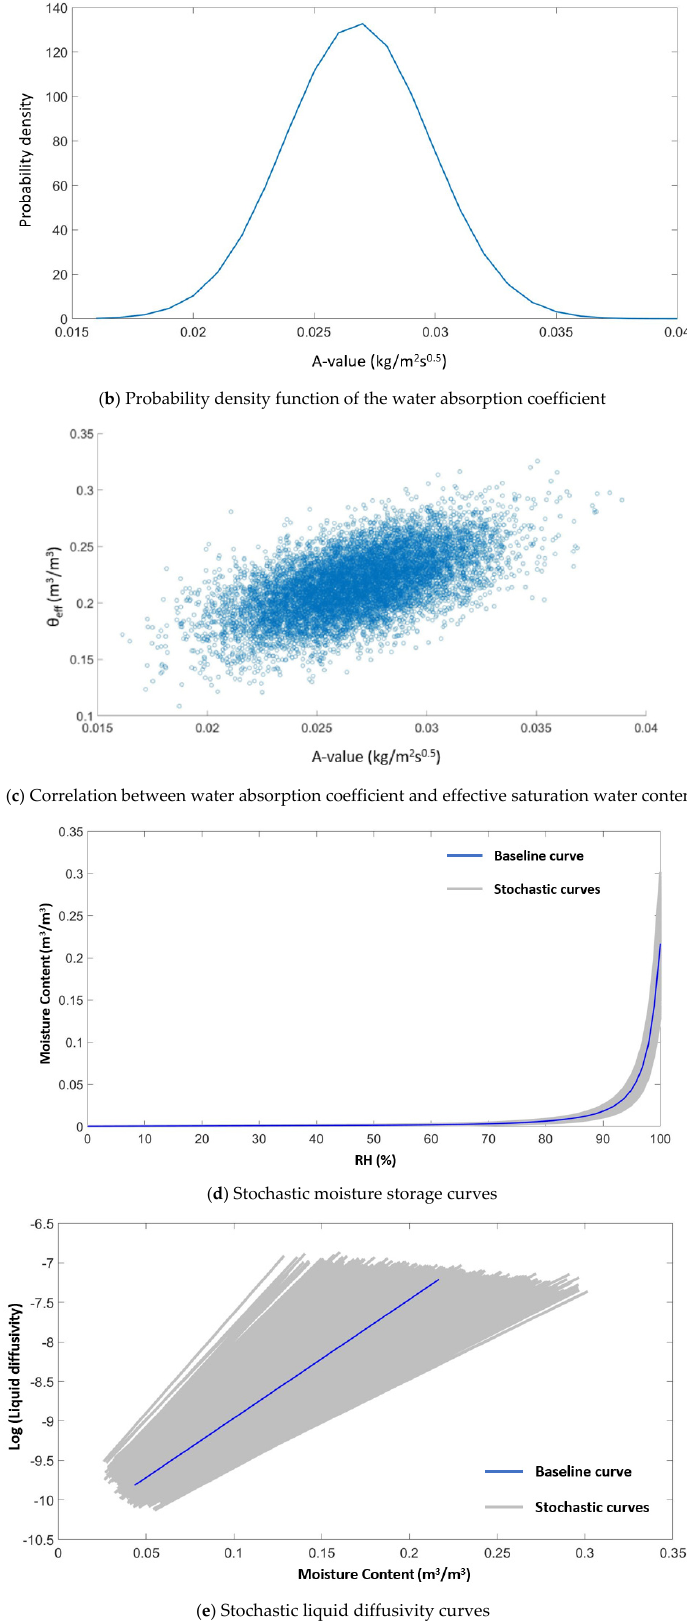
Figure 8. Stochastic brick properties.